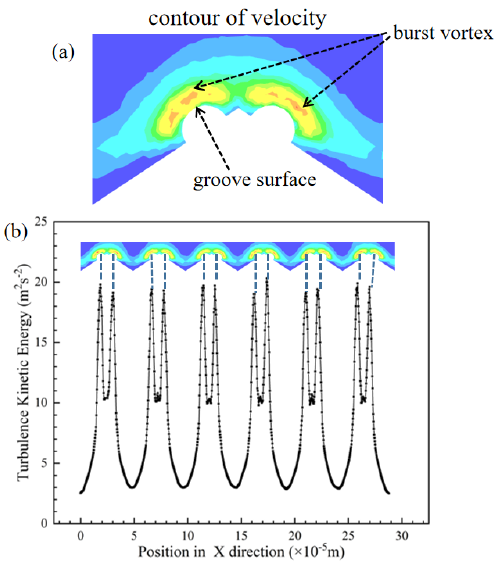
Figure 5. ( a ) Contour of velocity near the groove surface. ( b ) Curve of turbulent kinetic energy on the surface.